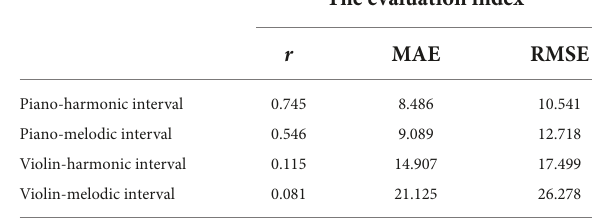
TABLE 6 The linear modeling results of the interval consonance index predicted by the multi-color perceptual attributes. The evaluation